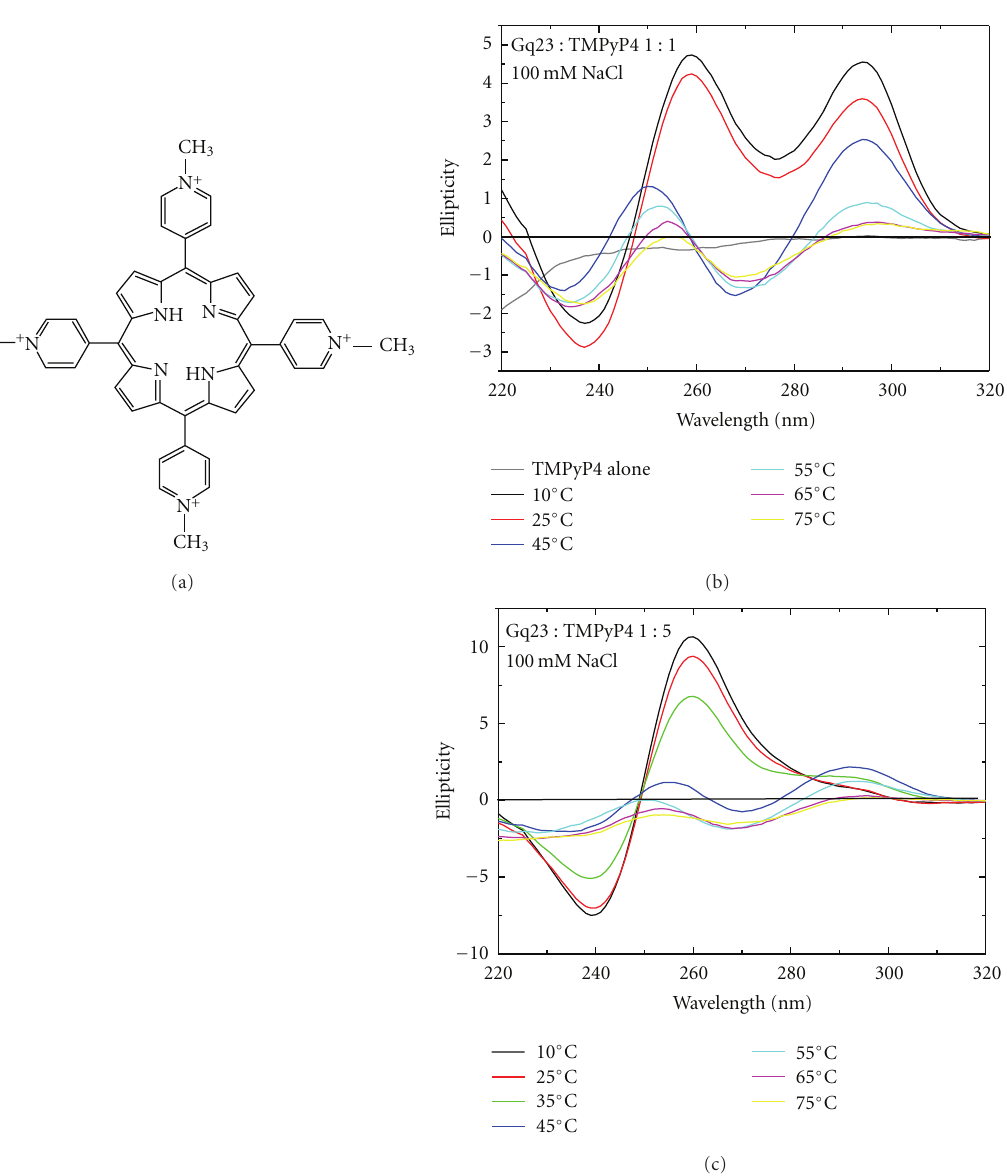
Figure 5: E ff ect of TMPyP4 on Gq23 in Na + ions. (a) Chemical structure of the porphyrin TMPyP4. TMPyP4 was combined with Gq23 in a 1:1 (b) or 1 :5 (c) molar ratio of Gq23